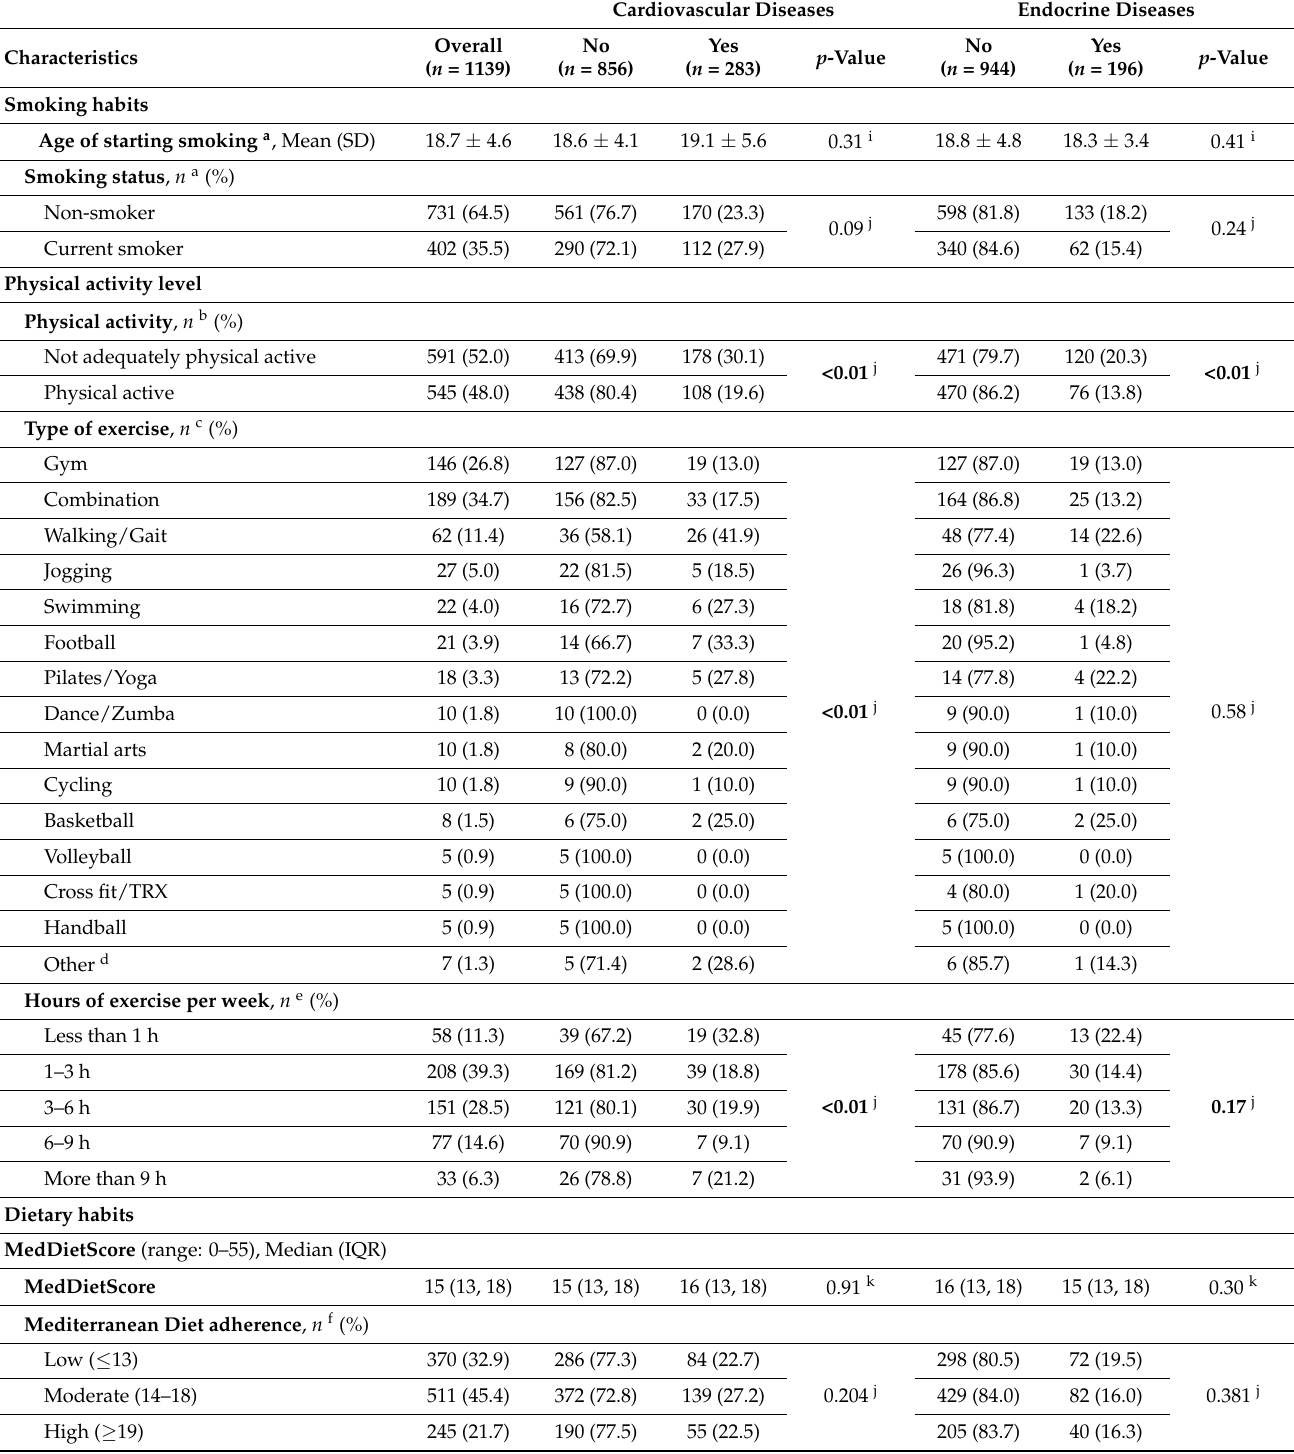
Table 2. Lifestyle factors overall, by participants with cardiovascular as well as with endocrine diseases. Cardiovascular